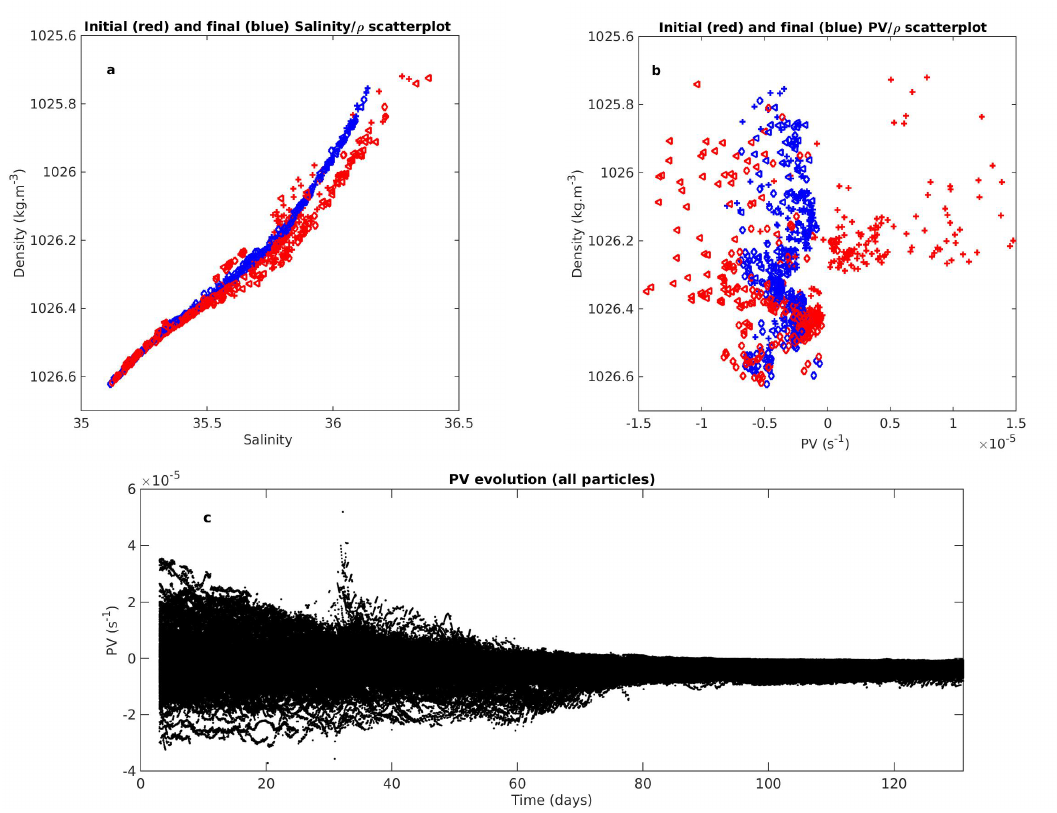
Figure 13. Initial (3rd of January, red color) and final (10 May, blue color) scatter-plot of salinity ( a ) and PV ( b ) against density. The (cid:5) , + , (cid:47) symbols are associated with PV classes described in the text; ( c ): evolution of PV for all particles.